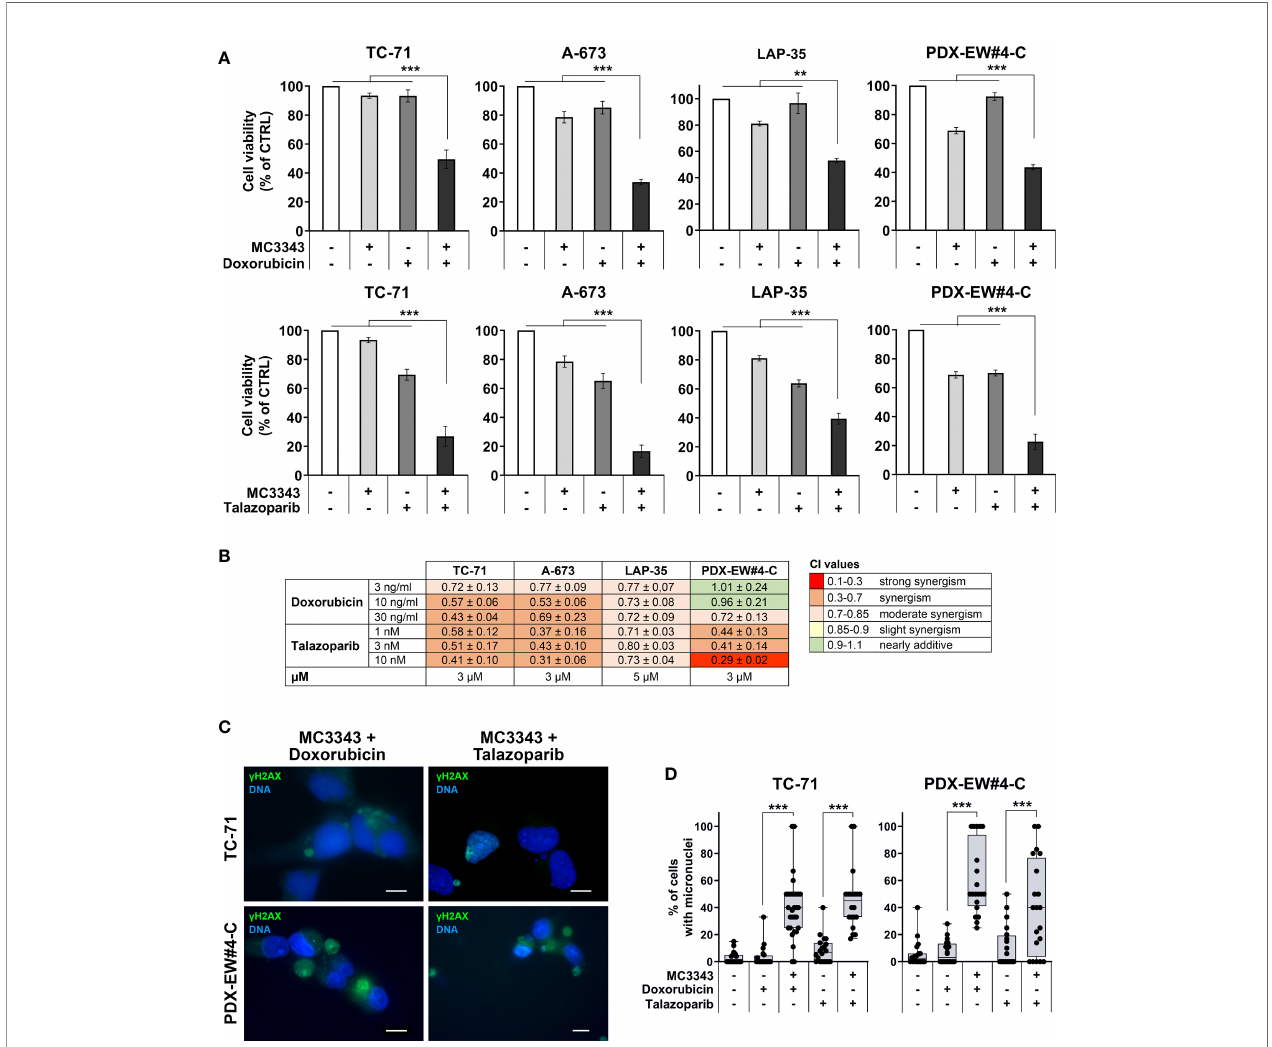
FIGURE 6 | Synergism of combined treatments with DNA damaging drugs. (A) TC-71, A-673, LAP-35 and PDX-EW#4-C cells were treated for 24h with 3-5 µM MC3343 and, after wash-out, treated for 48h with 3-10 ng/mL of doxorubicin or 3-10 nM of talazoparib. Cell viability was measured by trypan blue vital cell counts and is expressed as the percentage of live cells with respect to the untreated control. Data are shown as mean ± SE of three independent experiments (*p < 0.05; **p < 0.01, ***p < 0.001, one-way ANOVA test). (B) Heatmap of drug interactions of sequential treatments with MC3343 and doxorubicin or talazoparib. Cell viability was assessed by trypan blue cell counts. Synergistic, additive, or antagonistic drug interactions were calculated by combination index (CI). (C) Merged immuno fl uorescence of EWS cells staining for g H2AX (green) and DNA (blue) after treatment with MC3343 and doxorubicin/talazoparib as indicated. Representative images are shown. Scale bars, 10 µm. (D) Percentage of micro-nucleated cells after sequential treatment with MC3343 and doxorubicin or talazoparib. Data are presented as mean percentage of micro-nucleated cells quanti fi ed from at least 20 random fi elds (mean ± SE; ***p < 0.001, one-way ANOVA